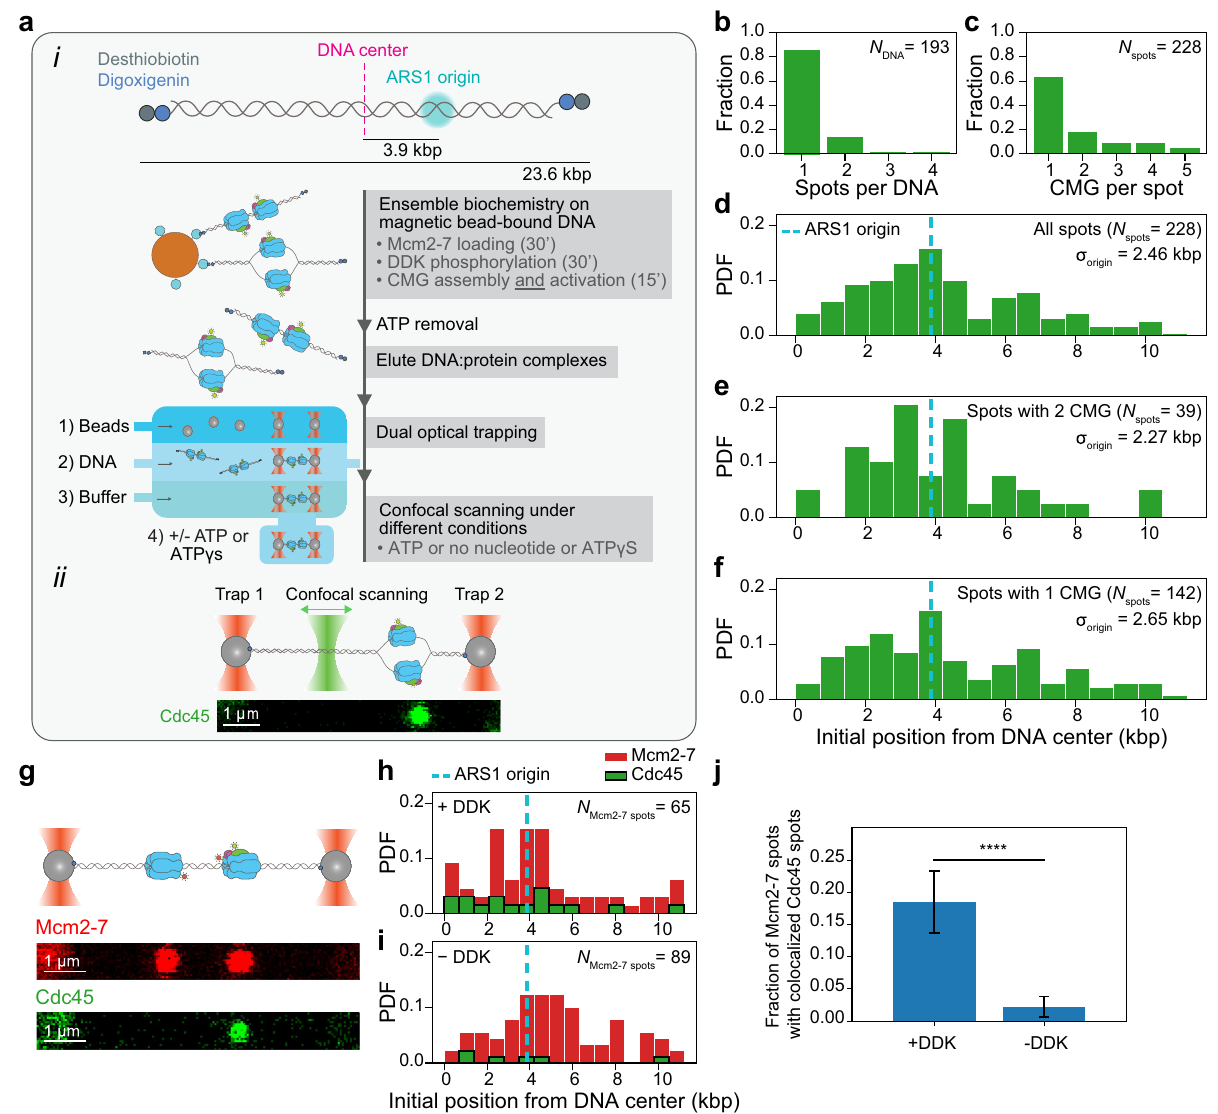
Fig. 1 | Single-molecule imaging of fully reconstituted CMG. a – i Description of hybrid ensemble and single-molecule assay to image fully reconstituted CMG. a-ii Example scan of an optically trapped DNA molecule containing one CMG diffraction-limitedspot. b DistributionofnumbersofCMGdiffraction-limitedspots per DNA. c Distribution of numbers of CMG complexes within each diffraction- limited spot. d – f Distribution of initial positions on the DNA of d all CMG diffraction-limited spots, e diffraction-limited spots containing 2 CMG complexes or f diffraction-limited spots containing 1 CMG complex; the ARS1 origin of repli- cation is indicated by the dashed cyan line. g Example scans separately showing